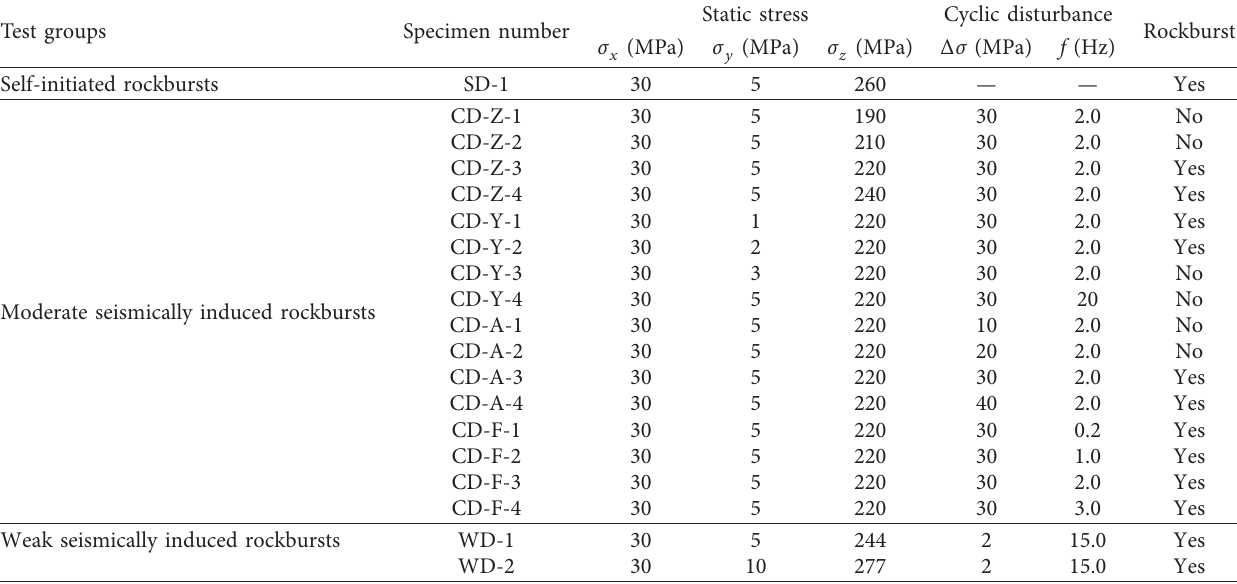
Table 1: Testing design of true triaxial rockburst